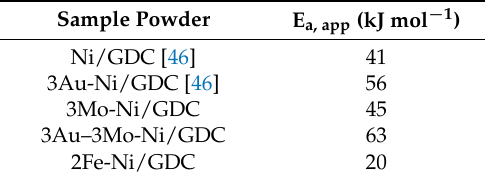
Table 2. Apparent activation energies (kJ mol − 1 ) for the dissociation of H 2 O on commercial Ni/GDC [46], and modified Ni/GDC samples. The values correspond to the slopes of the Arrhenius plots in Figure